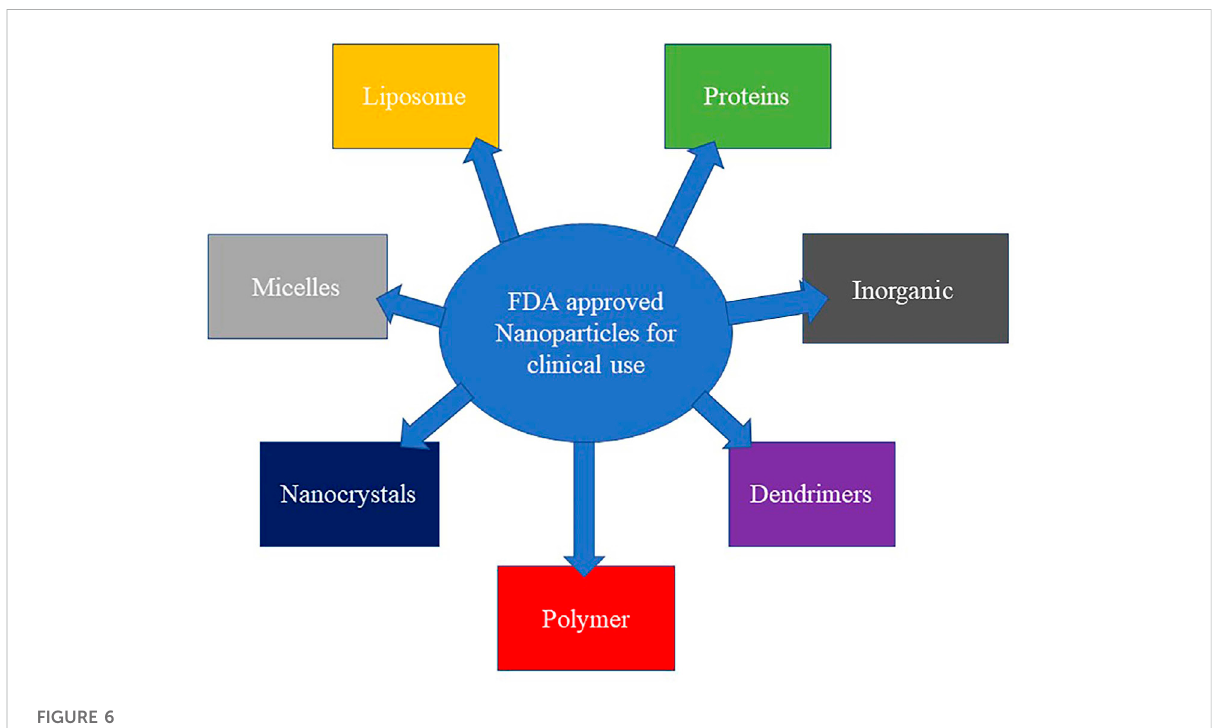
FIGURE 6 US FDA ’ s approved nanoparticles for clinical